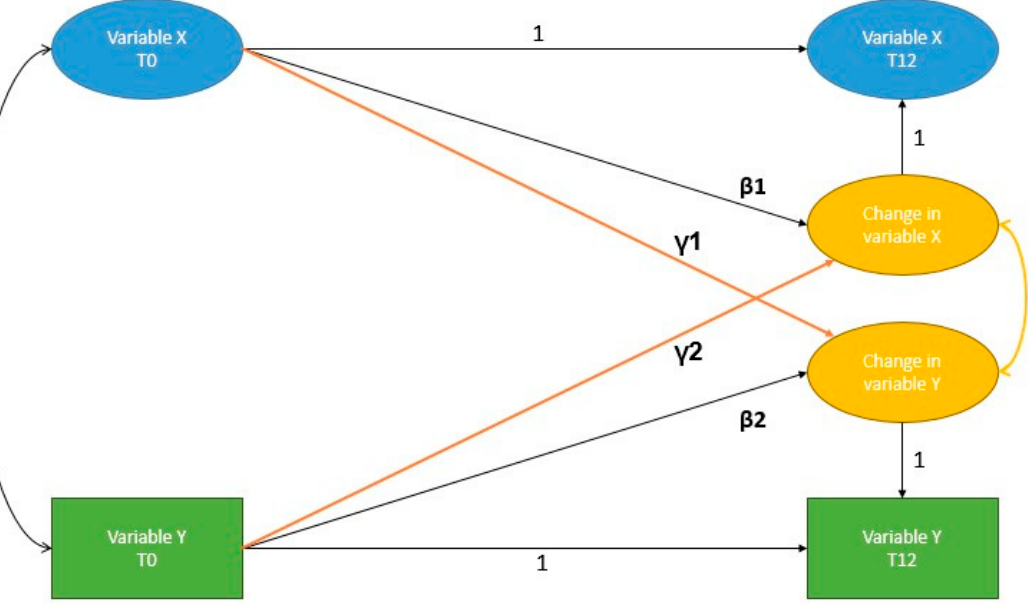
Figure 1. Specification of a bivariate latent difference score model ( β : autoregressive path; γ : coupling path; 1: path coefficient fixed to 1)